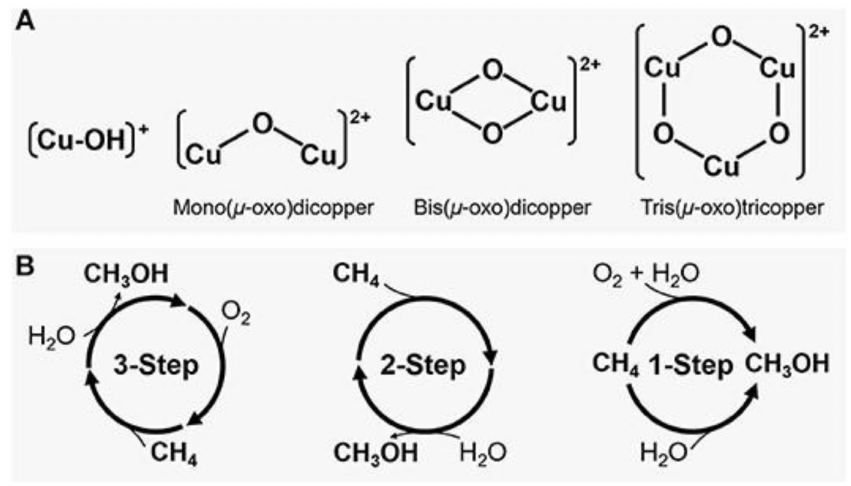
Figure 11. ( A ) Various proposed copper active species formed inside the zeolite pores and ( B ) Schemes for direct methane oxidation to methanol [187]. Copyright 2019, with permission from